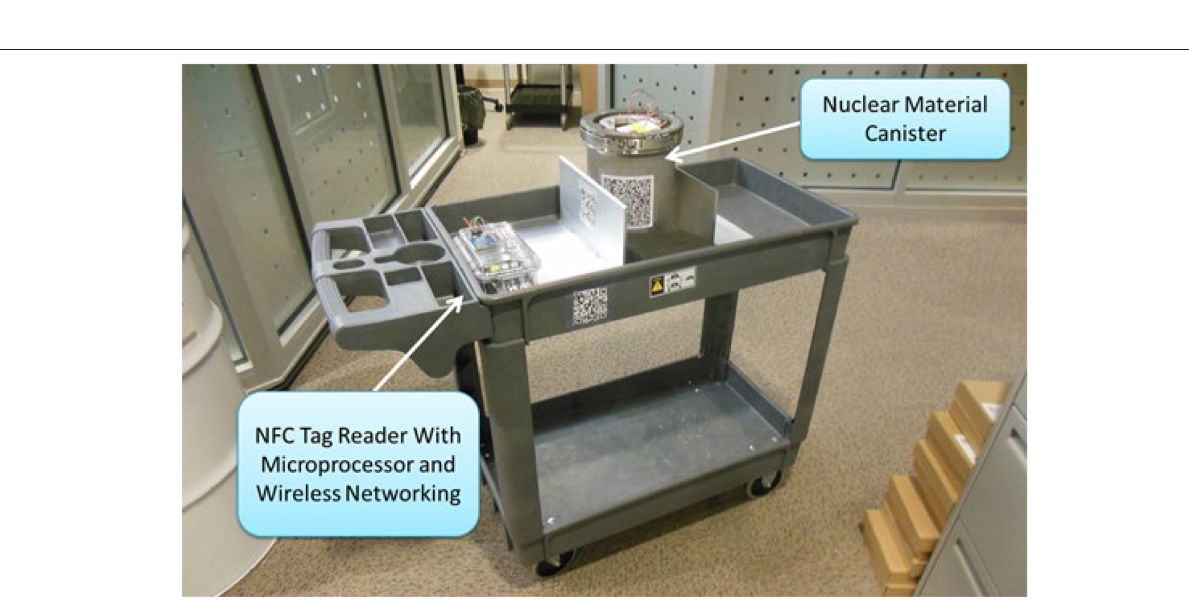
Frontiers in Built Environment |